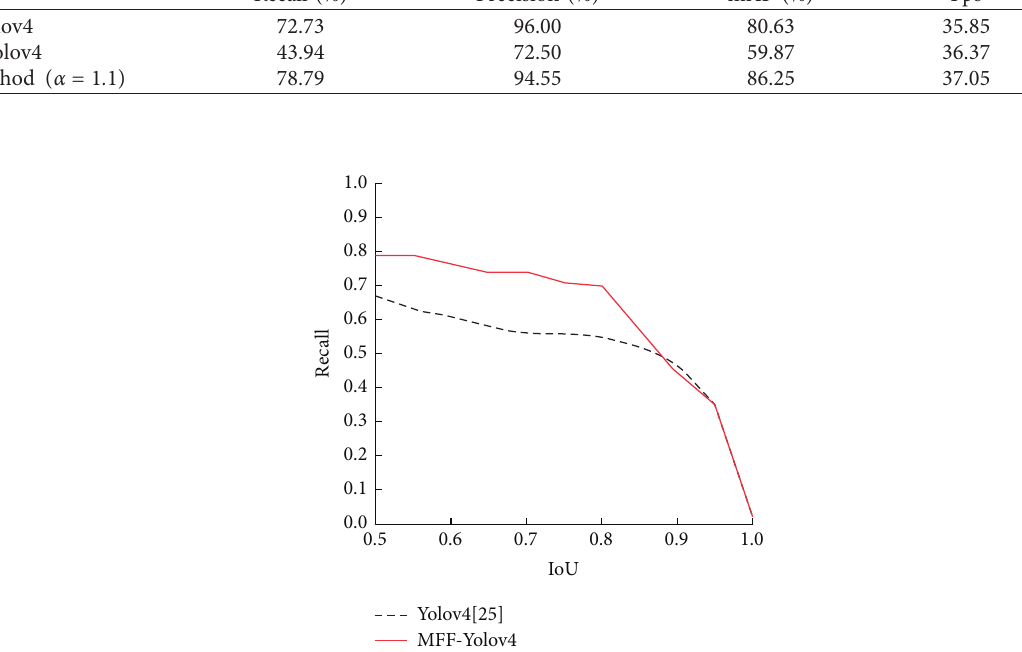
Figure 10: Recall rate under different IoU